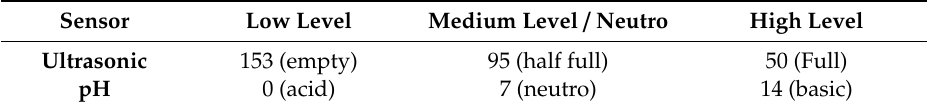
Table 3. Sensor levels to generate alerts.